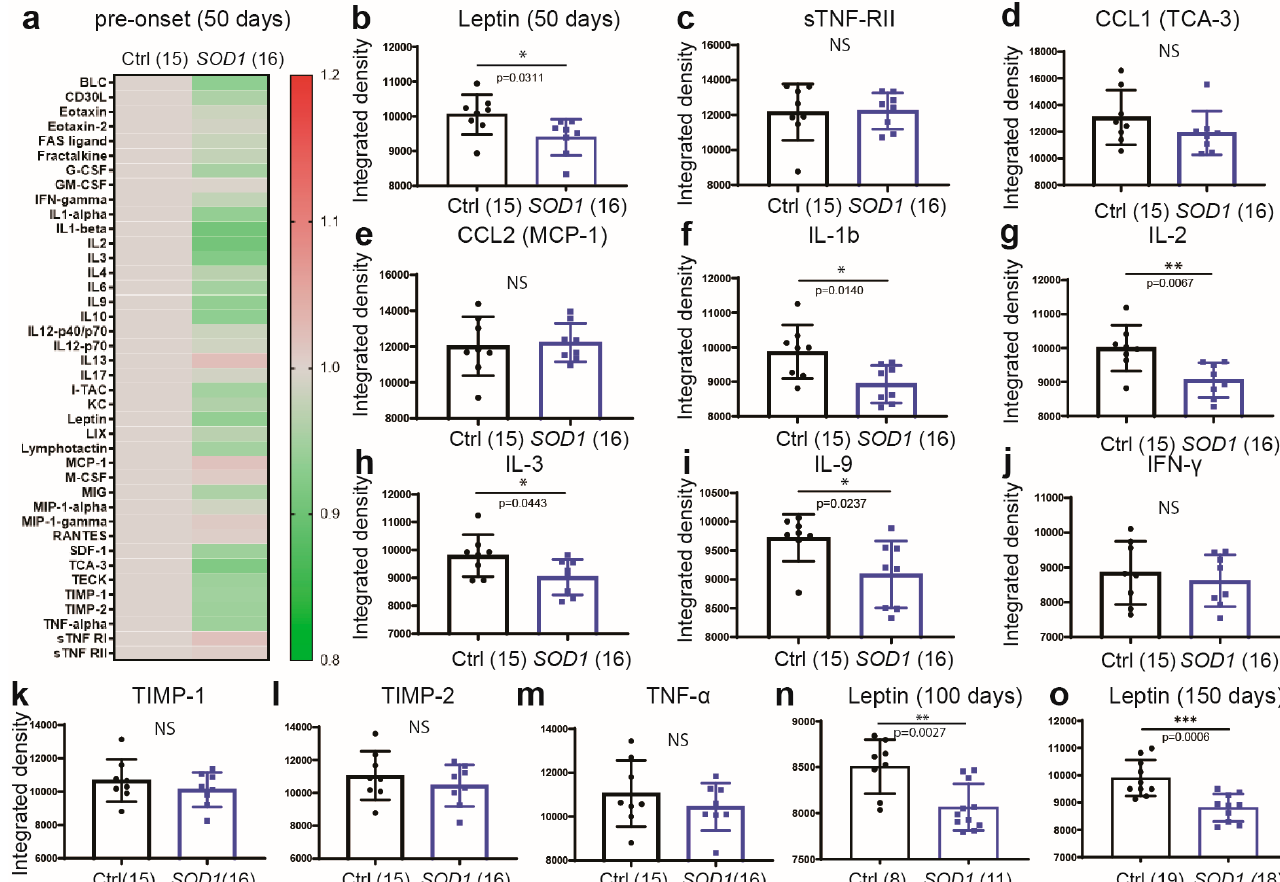
Figure 4. Plasma cytokine profile in pre ‐ onset SOD1 G93A mice. ( a ) Heat map illustrating cytokine changes (ratio) in SOD1 G93A mice as compared to non ‐ transgenic age ‐ matched mice. The total number of mice is in parentheses (ctrl female = 8, ctrl male = 7, SOD1 female = 9, SOD1 male = 7). Significant changes were detected in leptin ( b ), Il ‐ 1b ( f ), IL ‐ 2 ( g ), IL ‐ 3 ( h ) and Il ‐ 9 ( i ). Leptin levels in plasma of mild symptomatic (100 days) ( n ) and advanced stage (150 days) ( o ) SOD1 G93A mice. ( c – e , j , k , l , m ), the observed changes were not significant. (Data are mean ± SEM * p ≤ 0.05, ** p < 0.01, *** p < 0.001, NS, not significant).